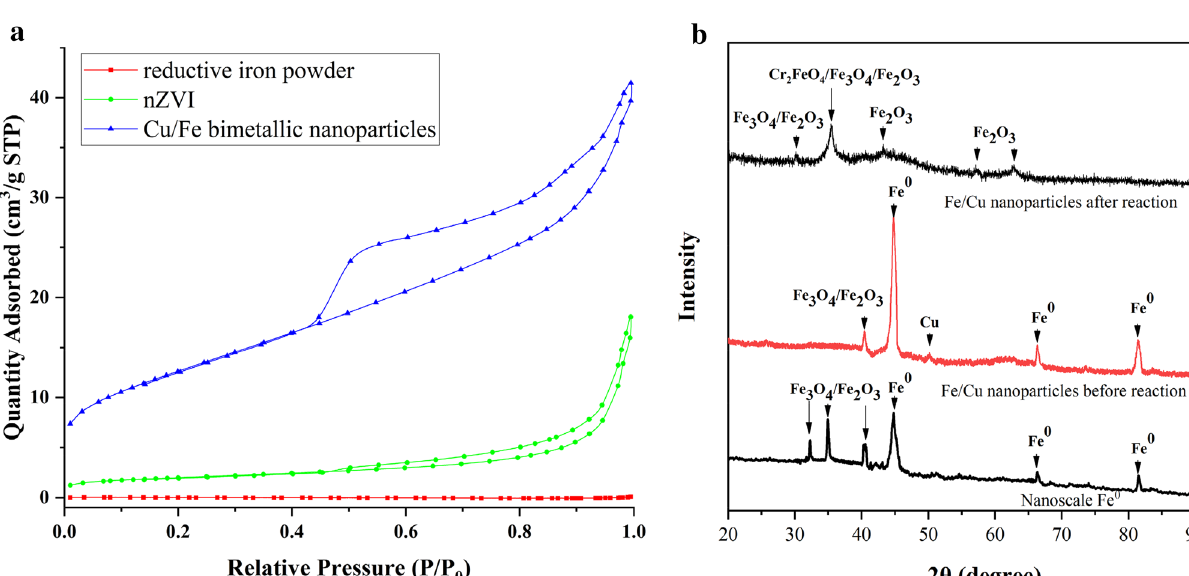
Figure 2. The adsorption–desorption isotherms of reductive iron powder, nZVI, and Cu/Fe bimetallic nanoparticles ( a ); XRD patterns of nZVI and Cu/Fe bimetallic nanoparticles ( b